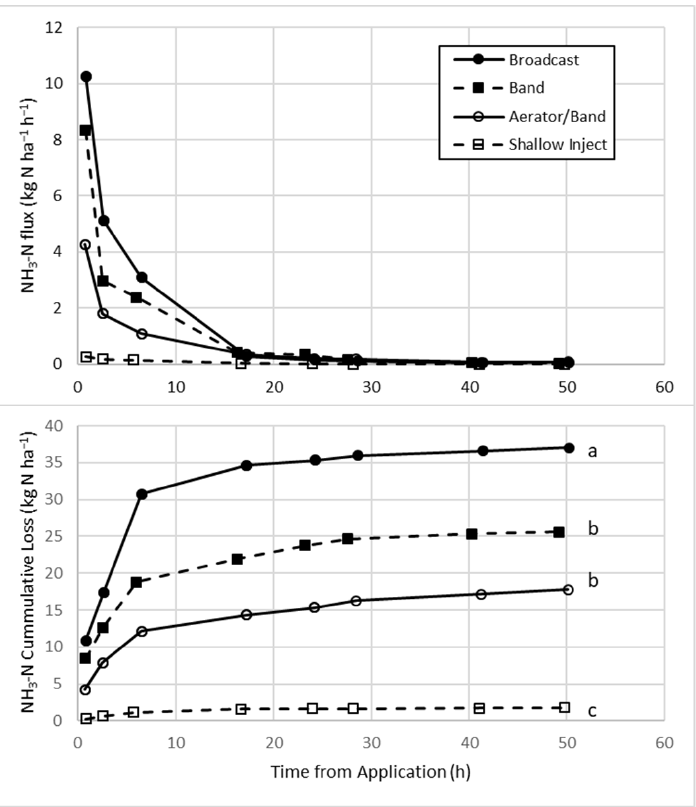
Figure 1. Average ammonia flux ( top ) and cumulative loss ( bottom ) for 2015 and 2016. Means without a common lower case letter differ at p <